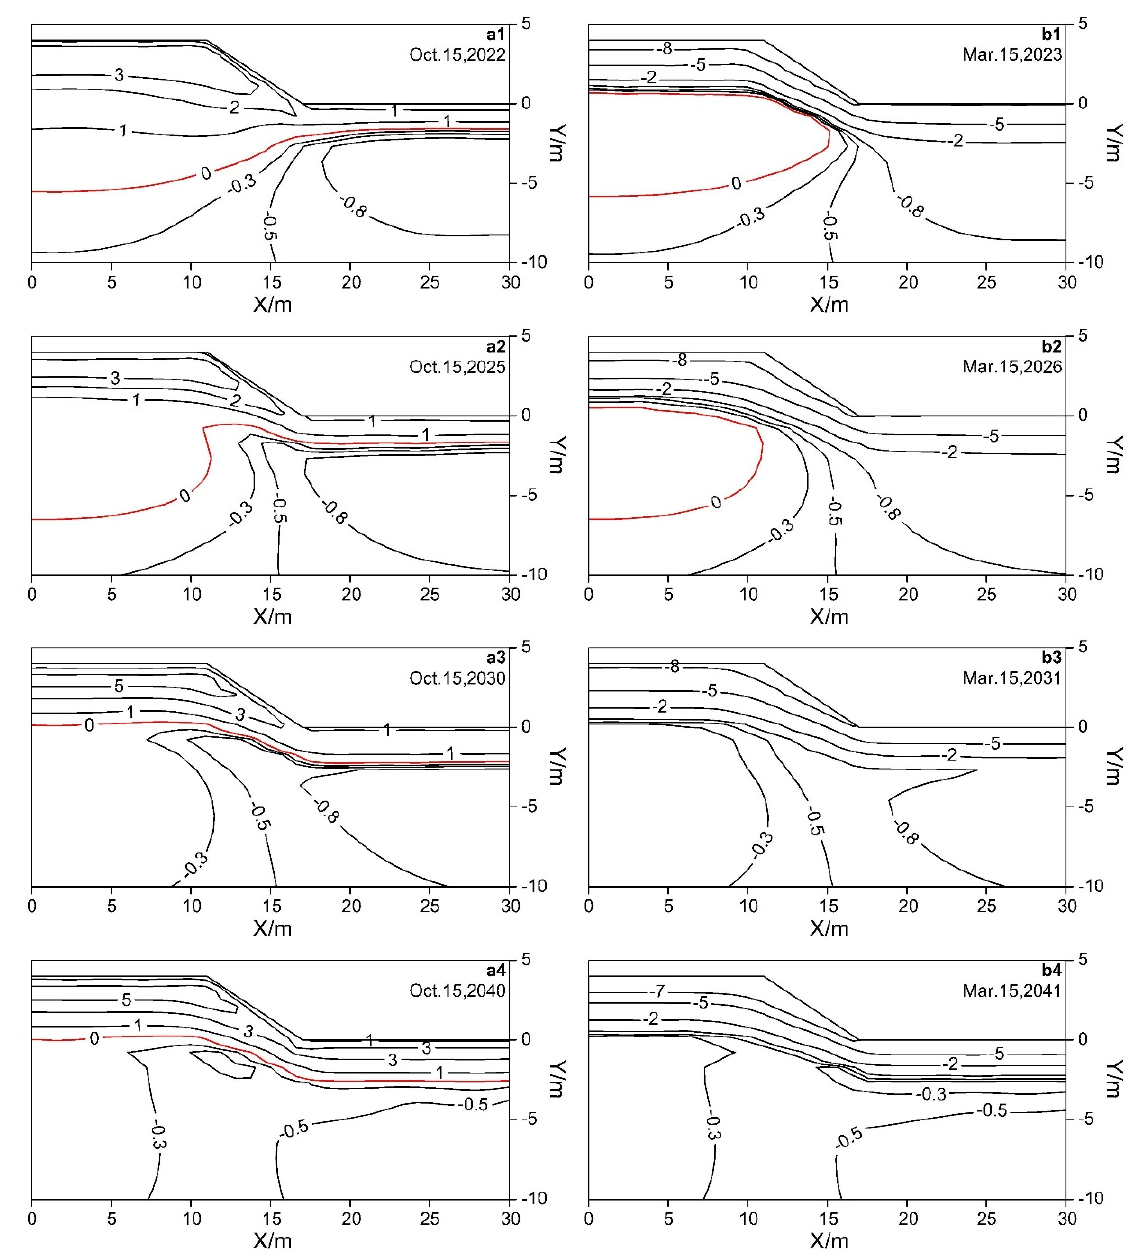
Figure 5. Ground temperature distributions in warm seasons and cold seasons in different years: ( a1 – a4 ) ground temperature distributions in warm seasons and ( b1 – b4 ) ground temperature distributions in cold seasons. (Unit: °C)